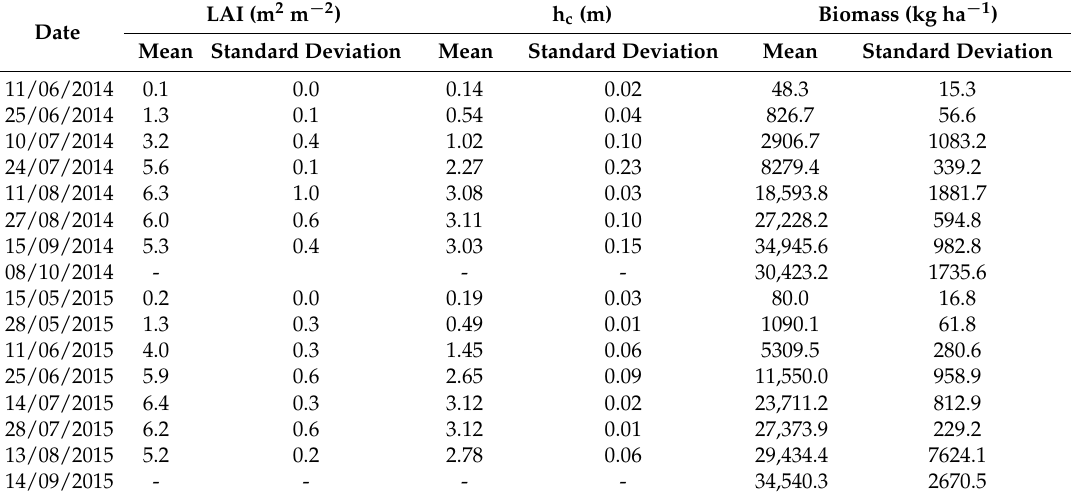
Table 3. Measured values of Leaf Area Index (LAI), canopy height (h c ) and aboveground dry biomass during the 2014 and 2015 crop